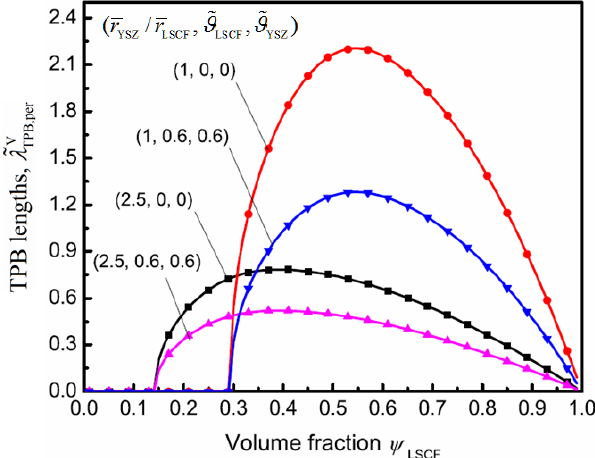
Figure 6. The non-dimensional percolated TPB